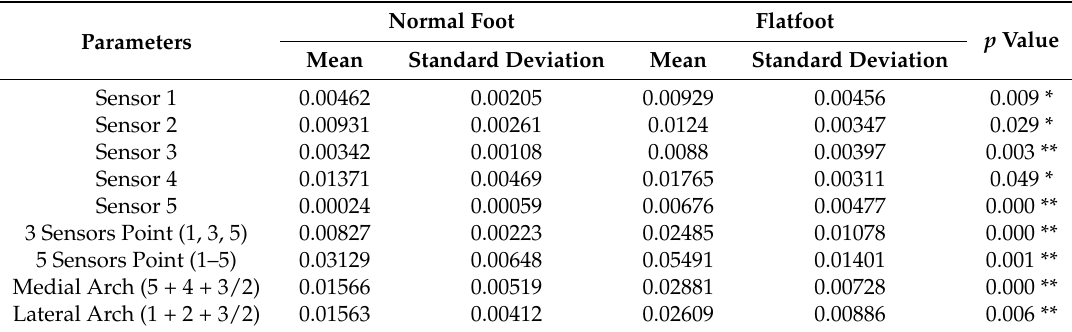
Table 3. Comparison of normal and flatfoot pressure value in the static trials.